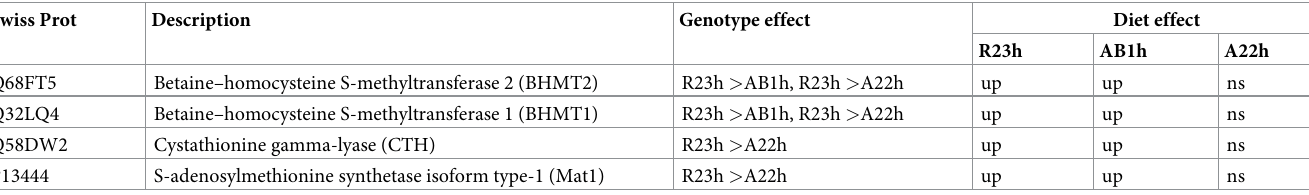
Table 5. Genes differentially expressed between the 3 isogenic lines related to amino acid metabolism. Swiss Prot